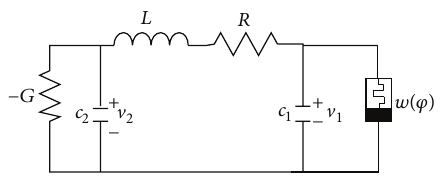
Figure 1: Chaotic system with memristor.